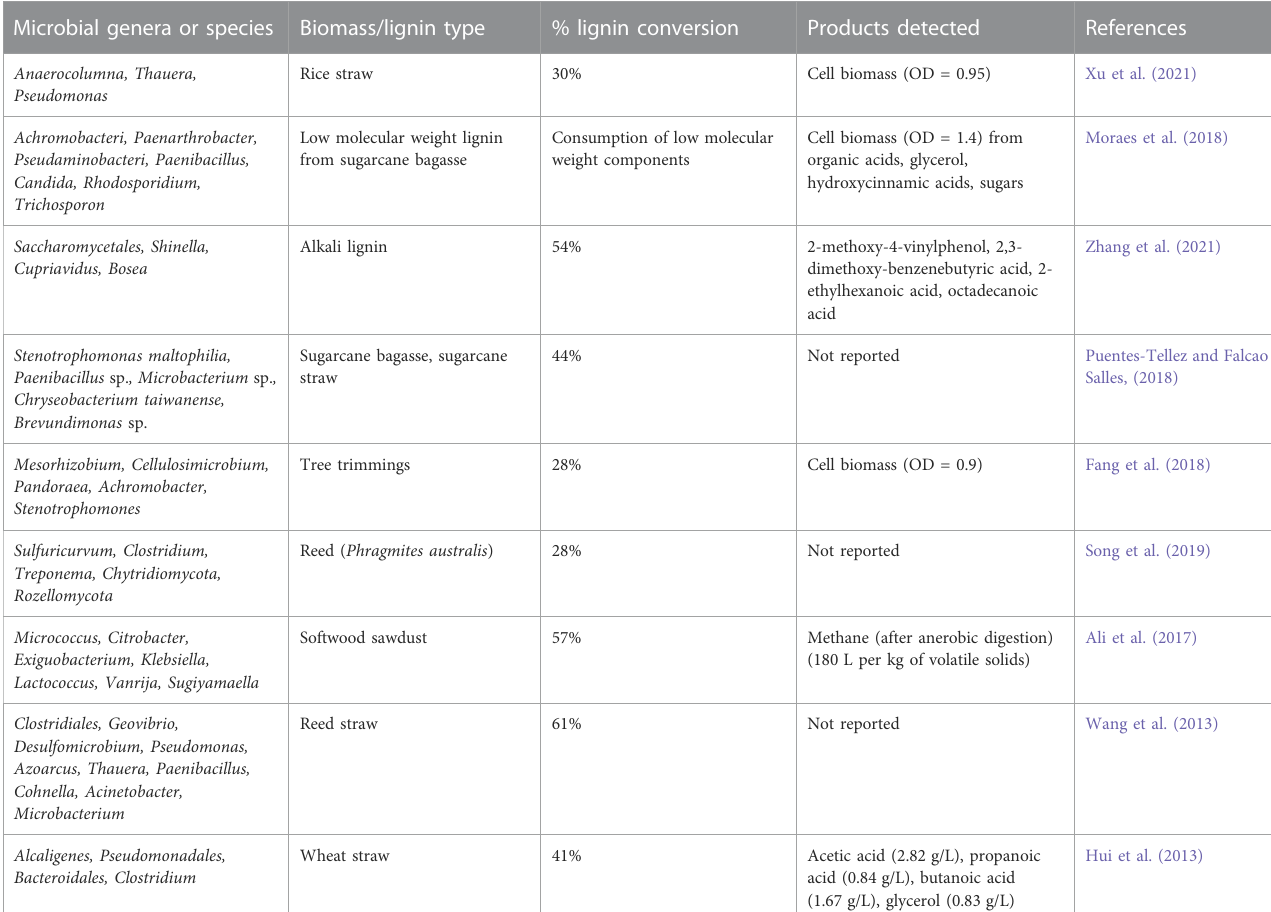
TABLE 1 Most abundant organisms present in microbial consortia with reported lignin conversion capabilities. Microbial genera or